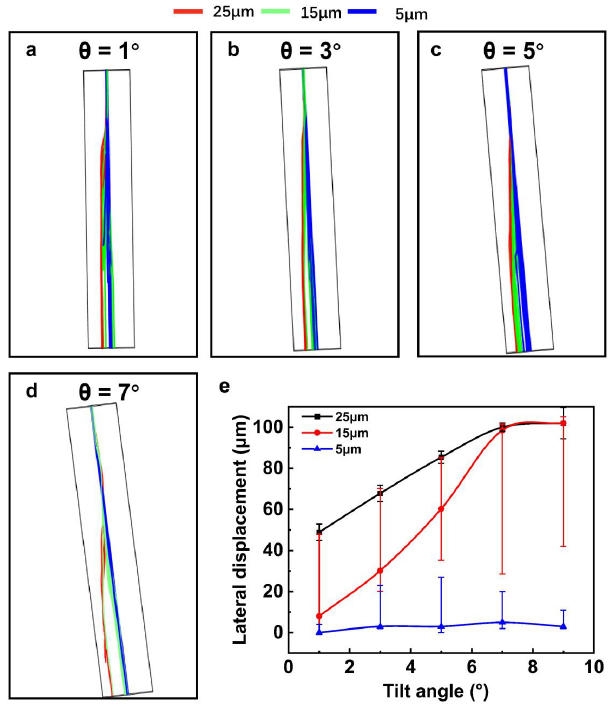
Figure 6. The particle trajectories under different slanted angles ( a – d ), the summary of the separa- tion distance at different slanted angles ( e ).